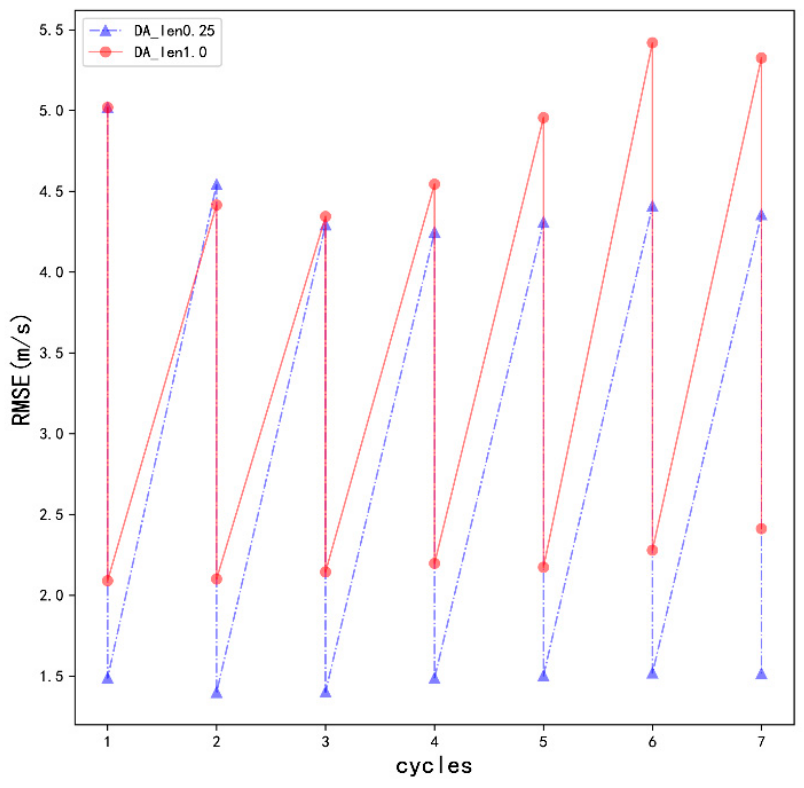
Figure 7. Root mean square errors (unit: m s − 1 ) of the radial wind speed between DA_len1.0 (red), DA_len0.25 (blue) and the observation during the cyclic assimilation.